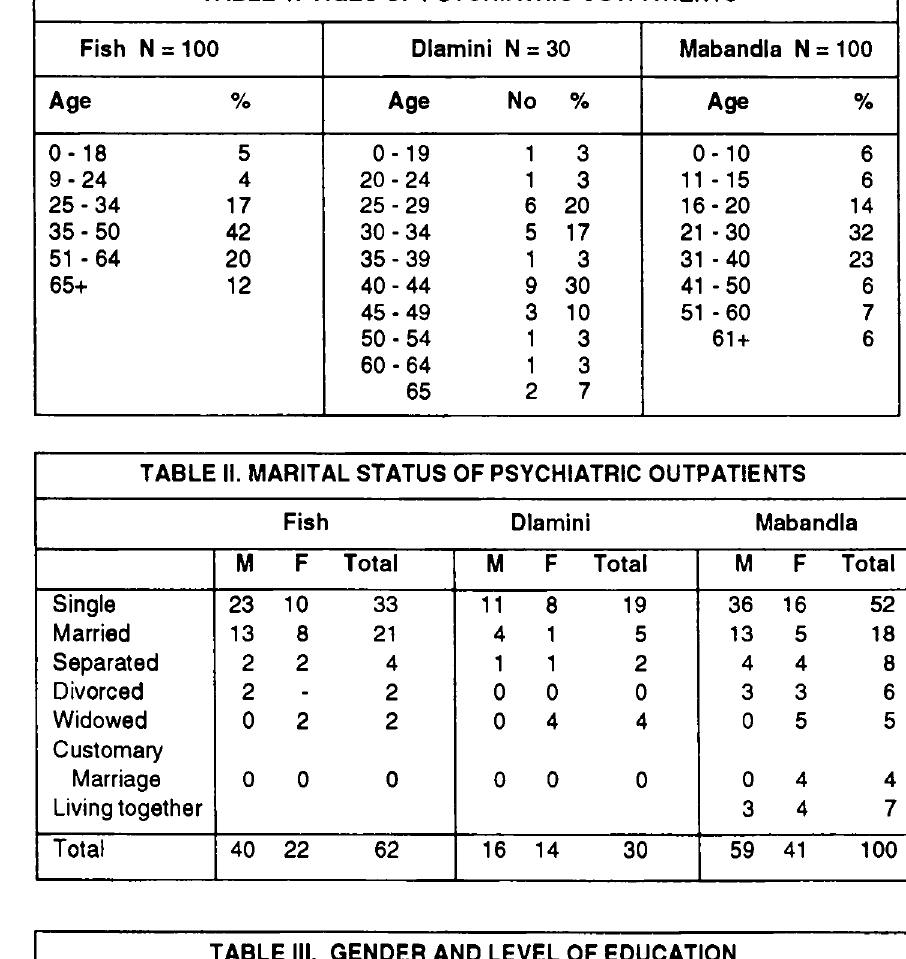
TABLE III. GENDER AND LEVEL OF EDUCATION